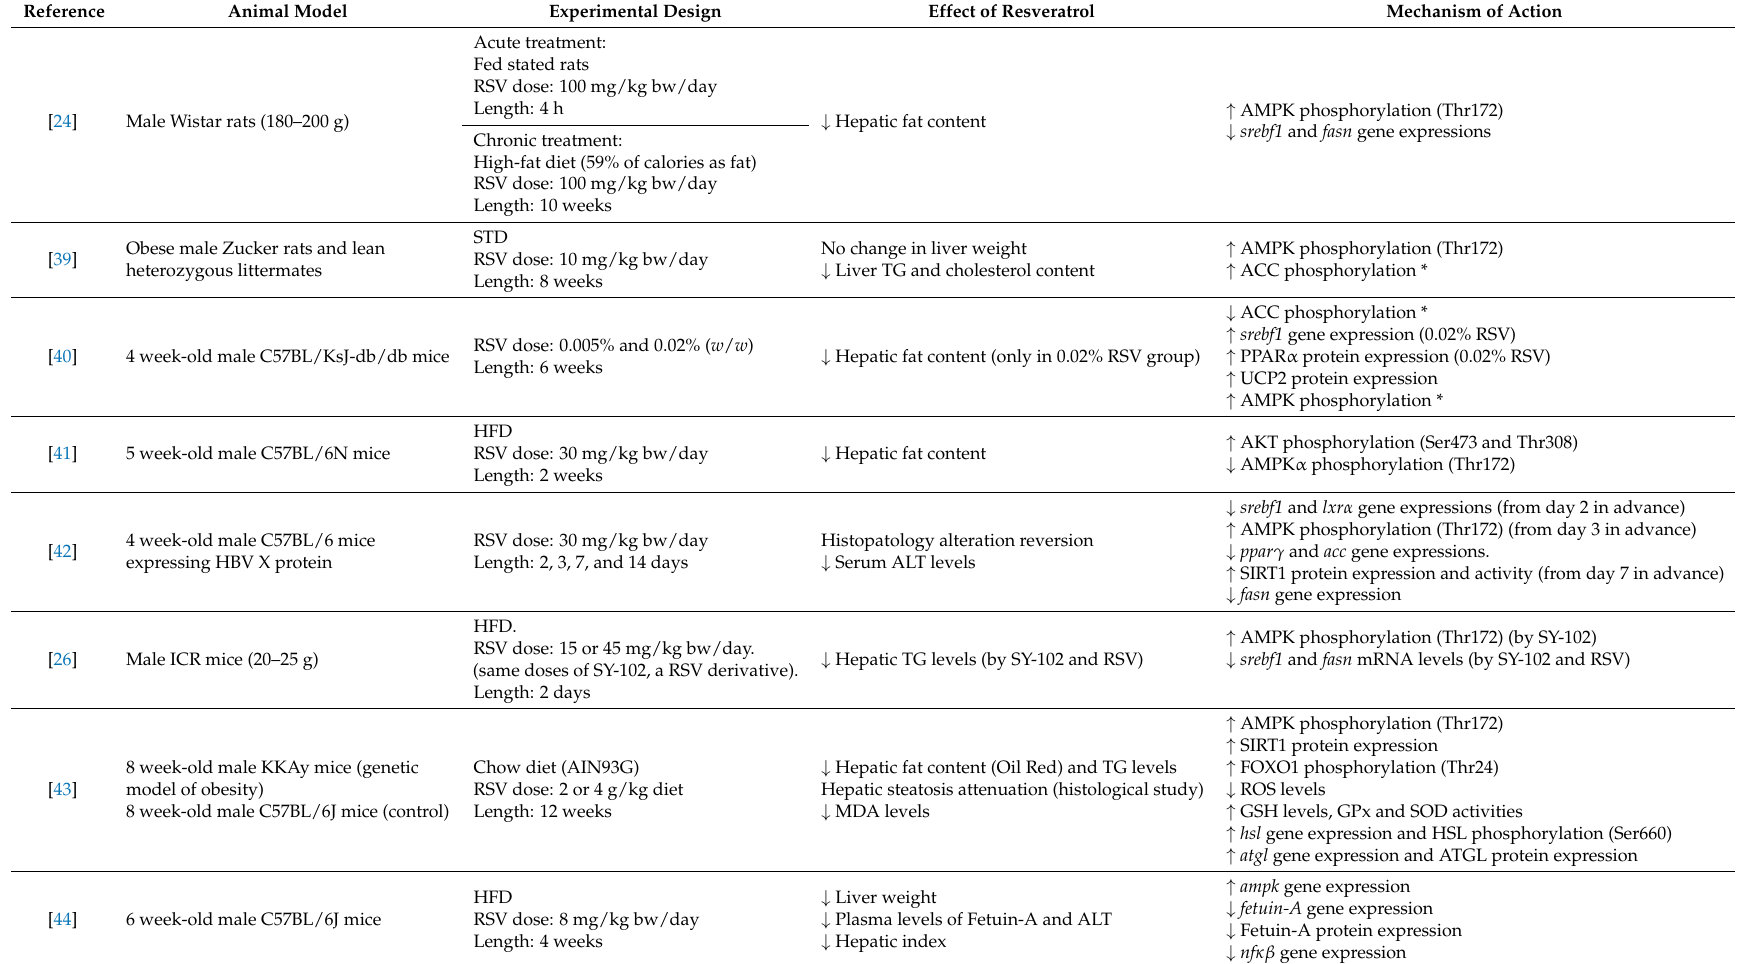
Table 3. Preclinical studies conducted in vivo to test the therapeutic effect of resveratrol on hepatic